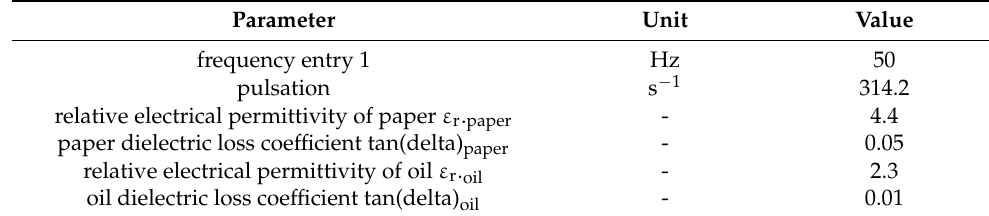
Table 1. Values of the components in Equation (6) used to calculate the dielectric losses. Parameter Unit Value frequency entry 1 Hz 50 pulsation s − 1 314.2 relative electrical permittivity of paper ε r . paper - 4.4 paper dielectric loss coefficient tan(delta) paper - 0.05 relative electrical permittivity of oil ε r . oil - 2.3 oil dielectric loss coefficient tan(delta) oil -